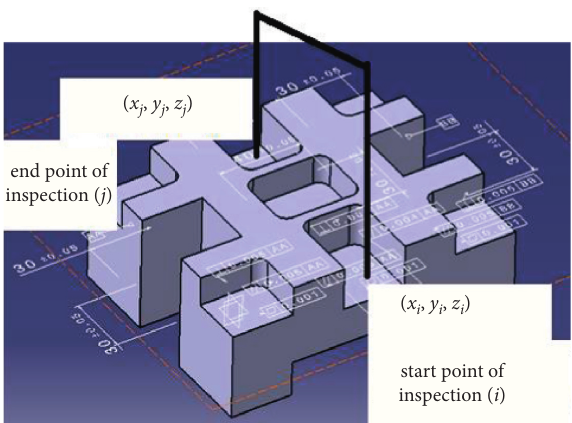
Figure 8: Probe path planning based on an objective